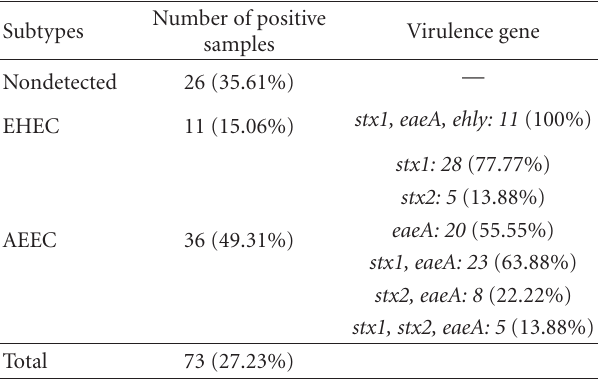
Table 6: Distribution of virulence factors in Escherichia coli subtypes isolated from bovine